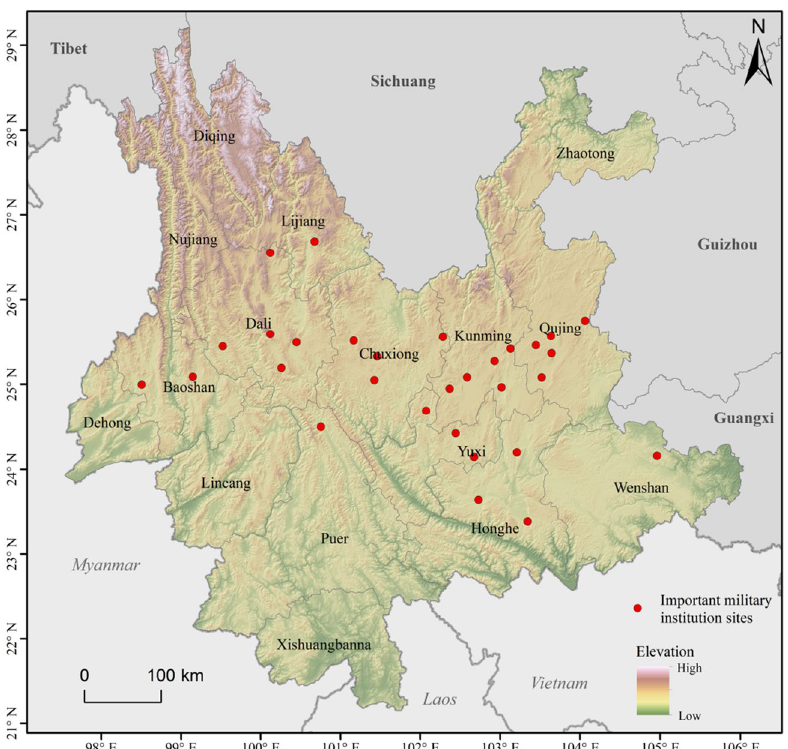
Figure 1. Location of Yunnan and important sites of WeiSuo military institution in the Ming Dynasty. The map was created in ArcGIS Pro v.2.7: https:// www. esri. com (Esri, California, USA). The final layout was created